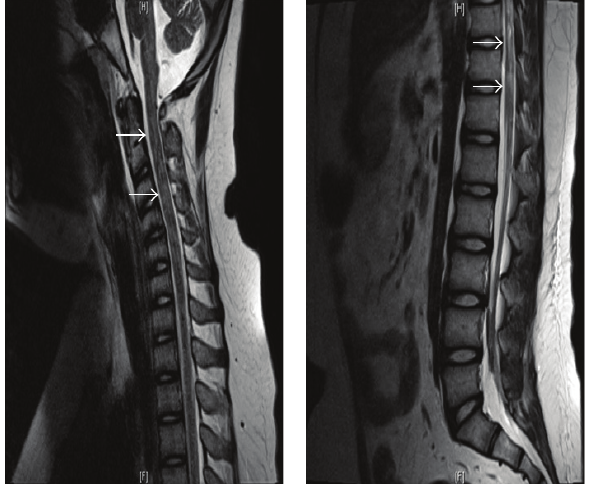
Figure 2: There are extensive lesions in the cervical spinal cord and lumbar spinal on T2